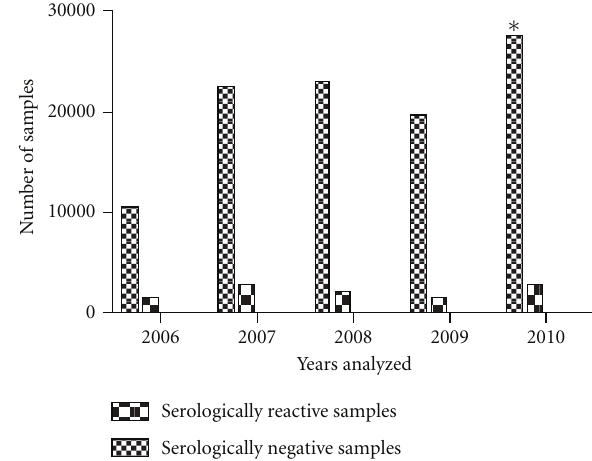
Figure 10: Chi-square testes to compare the proportions of serologically positive samples from 2006 to 2010. (There is no significant di ff erence between 2007 and 2008 ( P : 0 . 0874), the comparisons between the others pairs of years are significant di ff erent ( P < 0 . 0001). The proportion in 2010 is significantly greater than in 2009 ( P < 0 . 0014)— Z test for